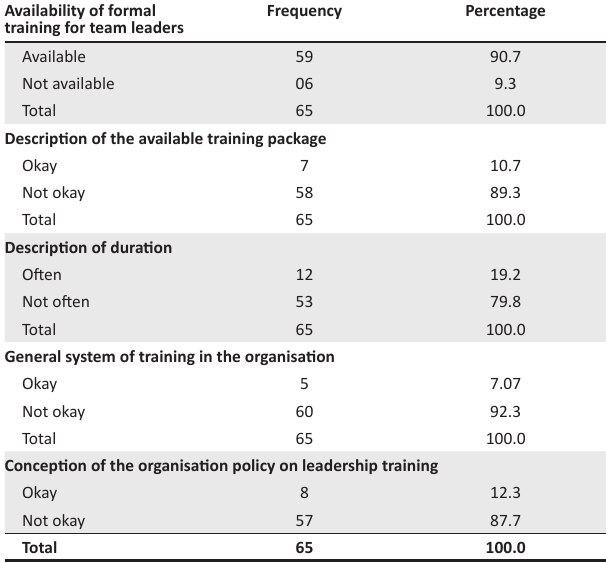
TABLE 1: Descriptive analysis of the training packages available for team leaders in the organisation.